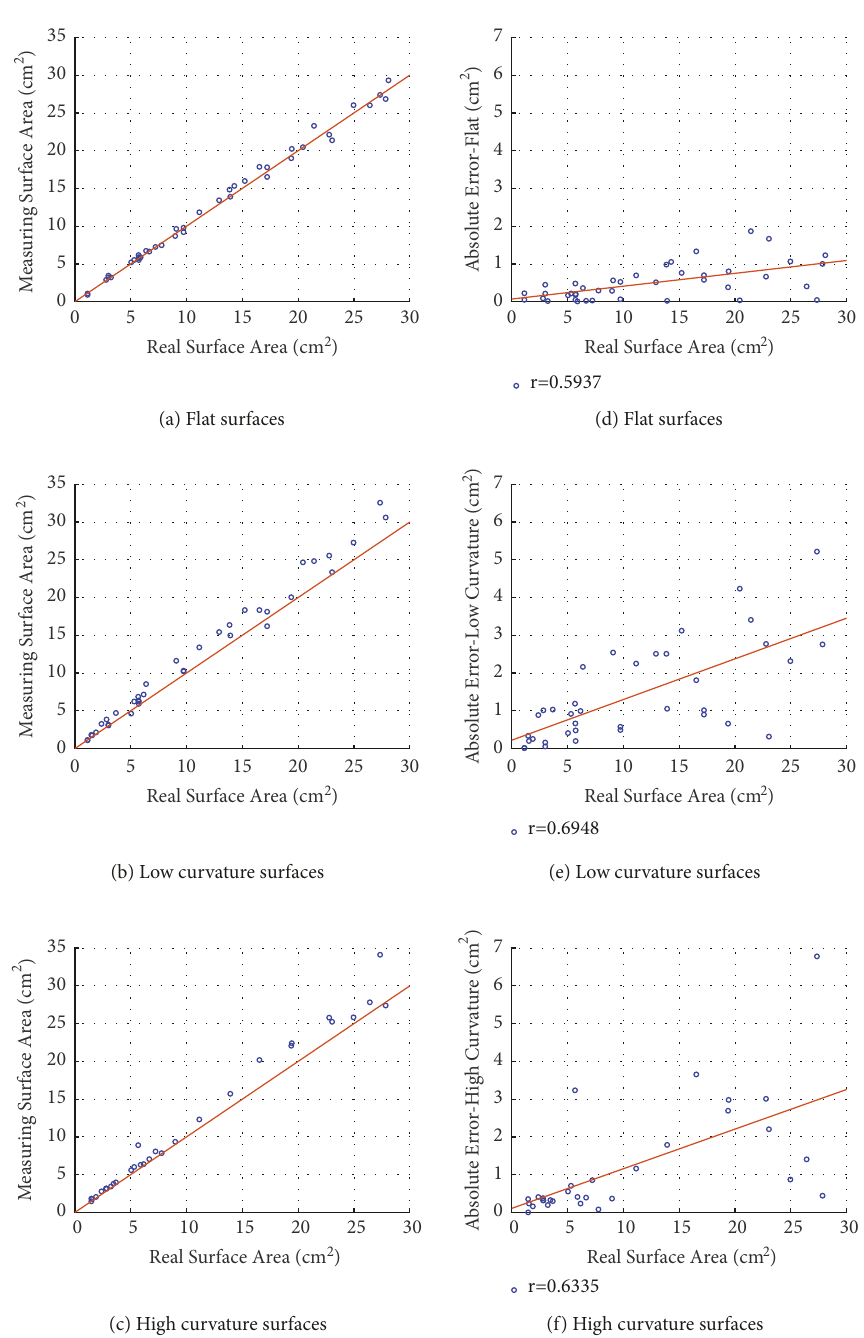
Figure 8: Comparison between the real surface area and the measured surface area for flat (a), low curvature (b), and high curvature (c) surfaces(linesrepresentidentities).Computedabsoluteerrorfortherealsurfaceareaandthemeasuringsurfaceareaforflat(d),lowcurvature (e), and high curvature (f) surfaces (lines represent regression